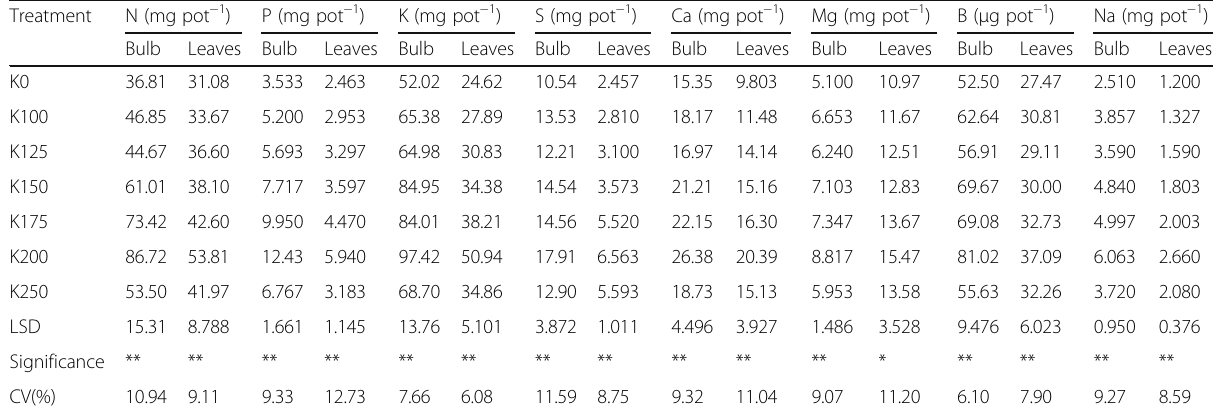
Table 4 Effect of different levels of K on N, P, K, S, Ca, Mg, B and Na uptake by bulb and leaves of garlic